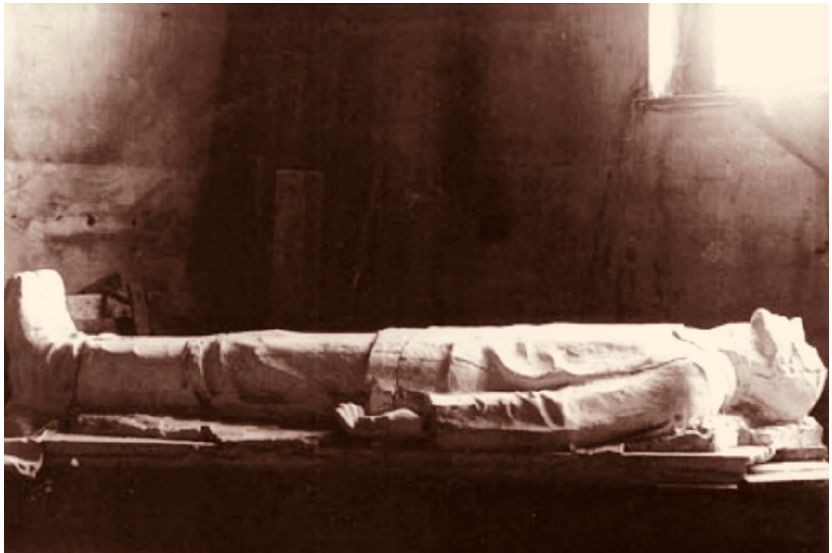
Figure 4. Käthe Kollwitz, Reclining Dead Soldier (Peter Kollwitz), 1915/16. Plaster, dimensions unknown, (presumed lifesize), lost. Model for a three-figure memorial (not completed). Photograph, Landesarchiv, Berlin. Photographer unknown.